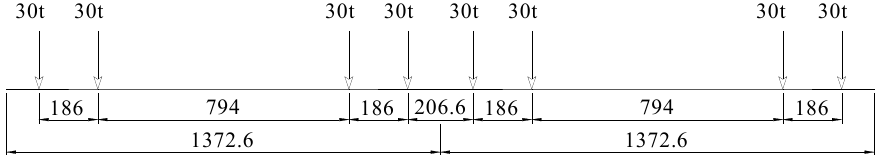
Figure 11. Parameters of the applied load (unit: cm).